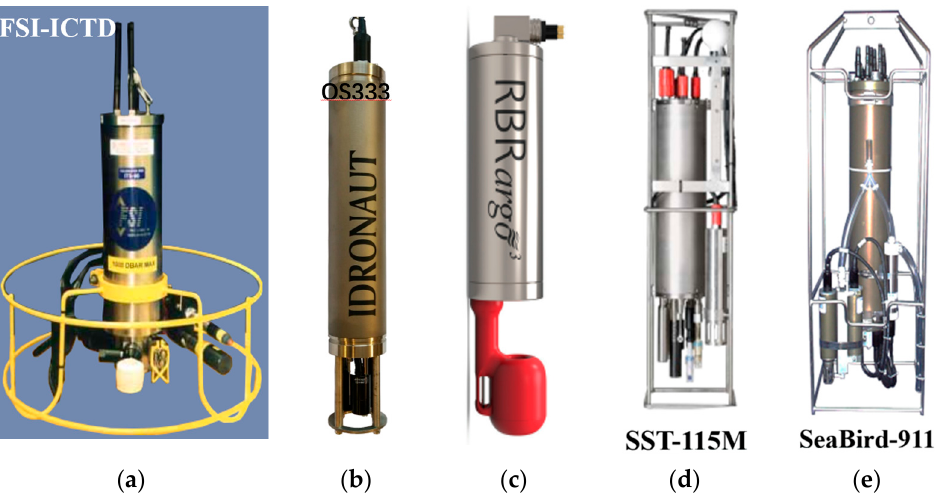
Figure 11. Representative CTD manufacturers and their products, ( a ) FSI-ICTD, ( b ) Idronaut-OS333, ( c ) RBR-argo3, ( d ) Sea Sun Tech-115M, ( e ) SeaBird 911plus. Table 4. Summary of representative commercially-available CTD products.